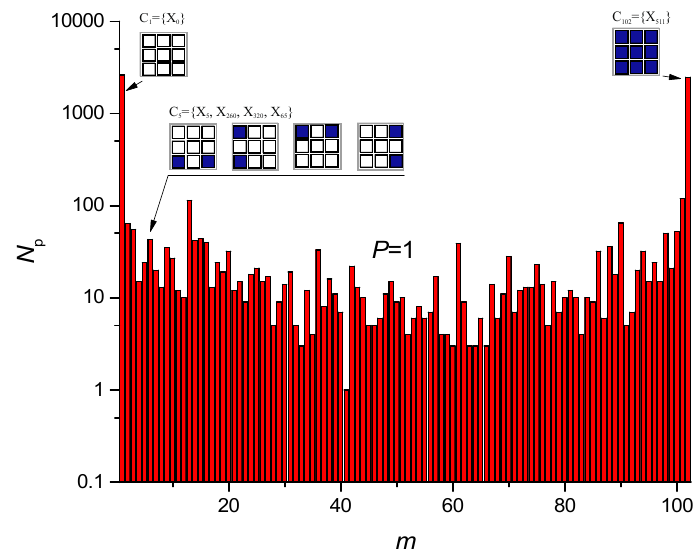
Figure 14. Distribution of the solutions number for problem I ( P = 1) according to the values m (4), calculated for 60 repetitions of the first step of training ( U n = 80 µV, η th =90%). Insets show the classes of input images C m for m = 1, m = 5, m = 102.